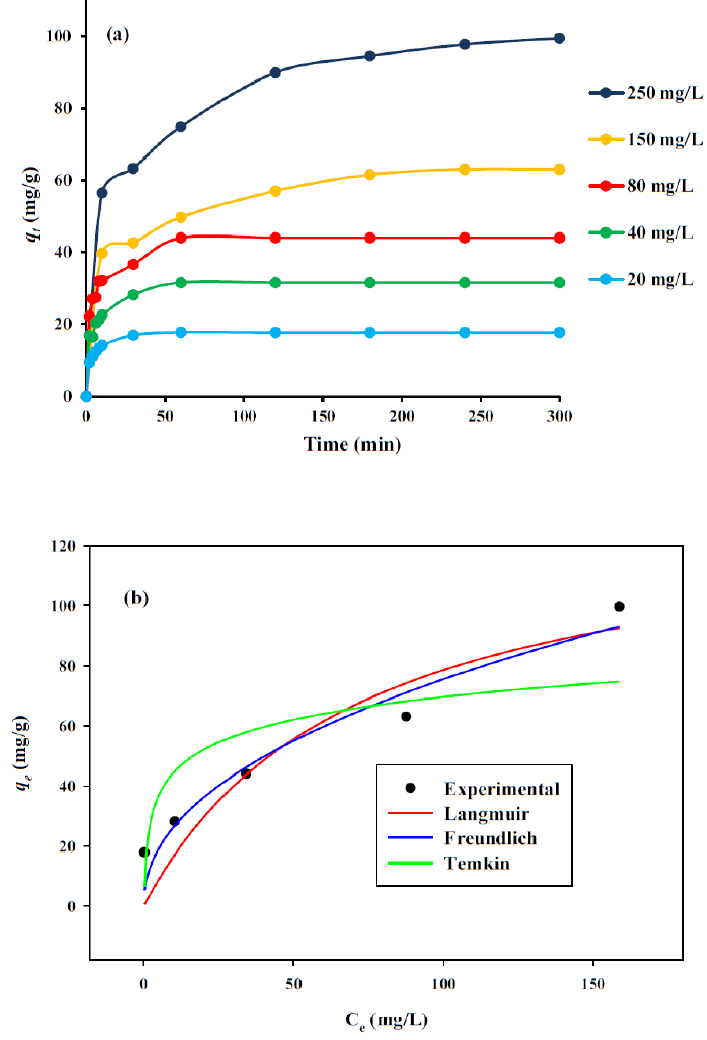
Figure 7. ( a ) Effect of MV 2B initial concentrations on adsorption ability of MCAC and ( b ) adsorption isotherms (Langmuir, Freundlich, and Temkin models) of MV 2B onto MCAC (dosage = 0.097 g, solution pH = 9.12, temperature = 25 °C, agitation speed = 90 rpm, and volume of solution = 100 mL). Table 6. Adsorption kinetics and non-linear isotherm